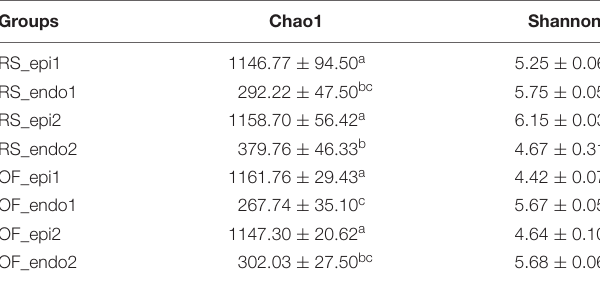
TABLE 2 | α diversity indices (Chao1 and Shannon) of the epiphytic and endophytic bacterial community of “Hongyang” and “Cuiyu” kiwifruit grown under rain-shelter and open-field cultivation